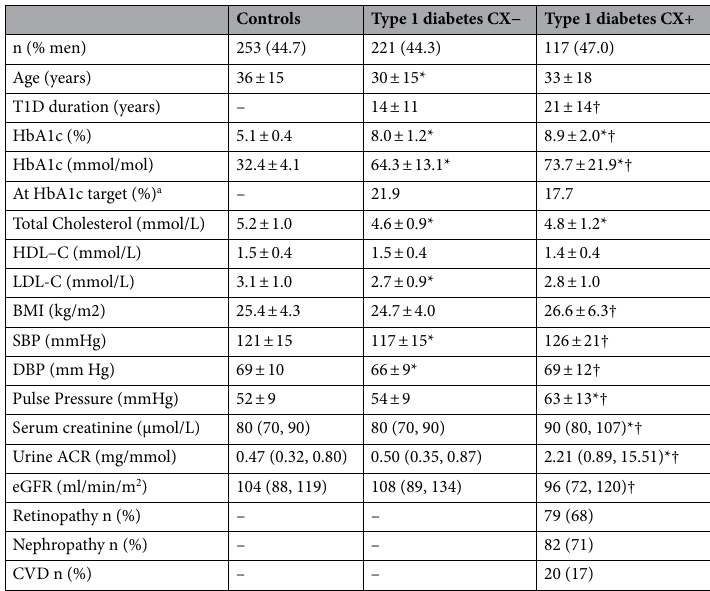
Table 1. Clinical characteristics of participants with and without diabetes. Data shown: mean ± SD or median (LQ, UQ). * p < 0.05 versus CON. † p < 0.05 versus Type 1 diabetes CX-. a HbA1c target: ≤ 7% (53 mmol/mol) for adults, ≤ 7.5% (58 mmol/mol) for